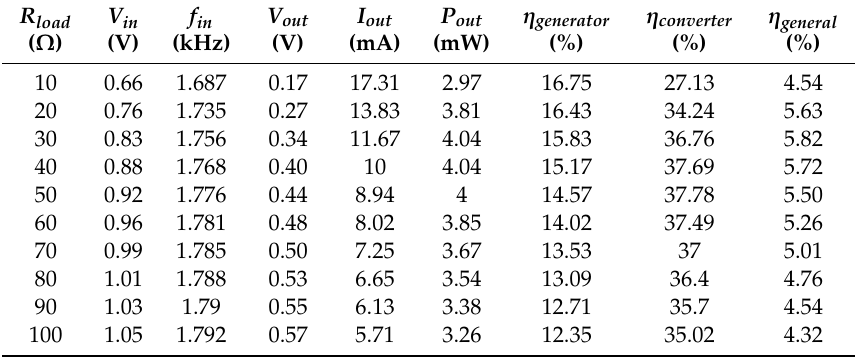
Table 21. Diode bridge simulation results under the minimum input condition.